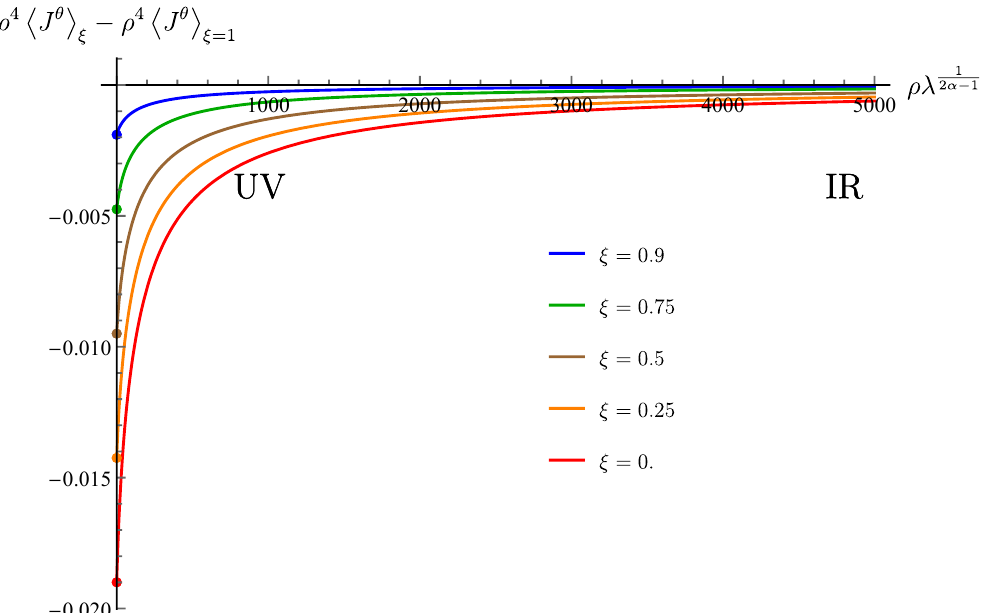
(cid:10) (cid:11) (cid:10) (cid:11) J θ − ρ 4 J θ as a function of ρλ 1 / (2 α − 1) for d = 4 , α = 0 . 75 , and ξ ξ =1